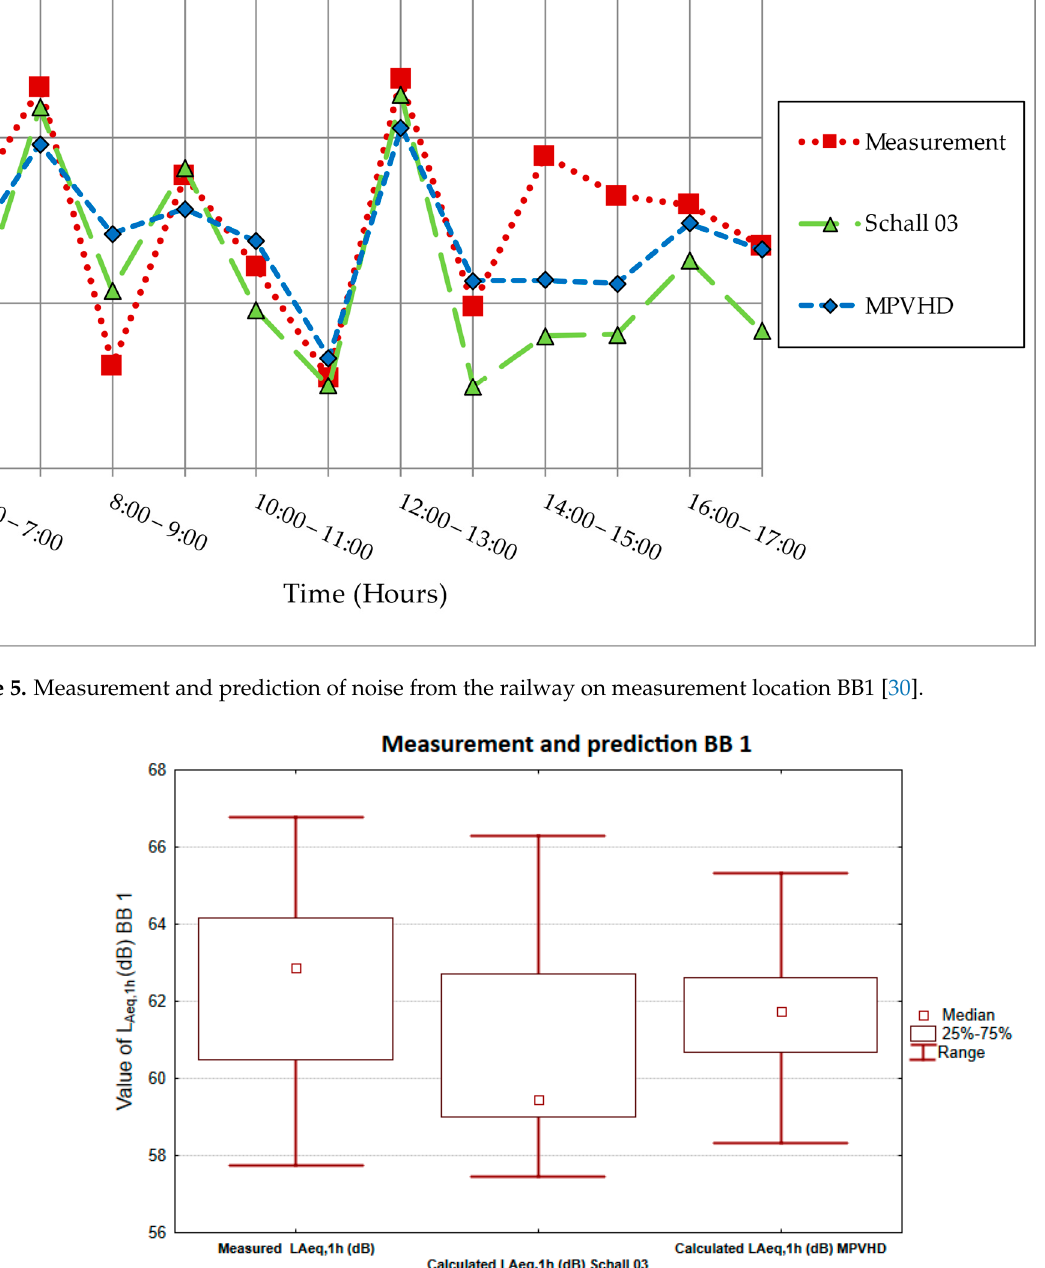
Table 3 . Number and type of trains during the measurement BB2. Direction Banská Bystrica- Č ervená Skala